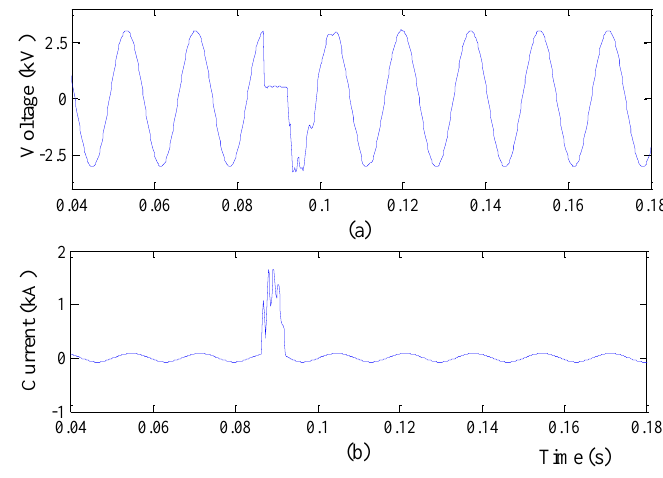
Figure 1. Sub-cycle incipient fault (IF) event at fault location: ( a ) voltage; ( b ) current.